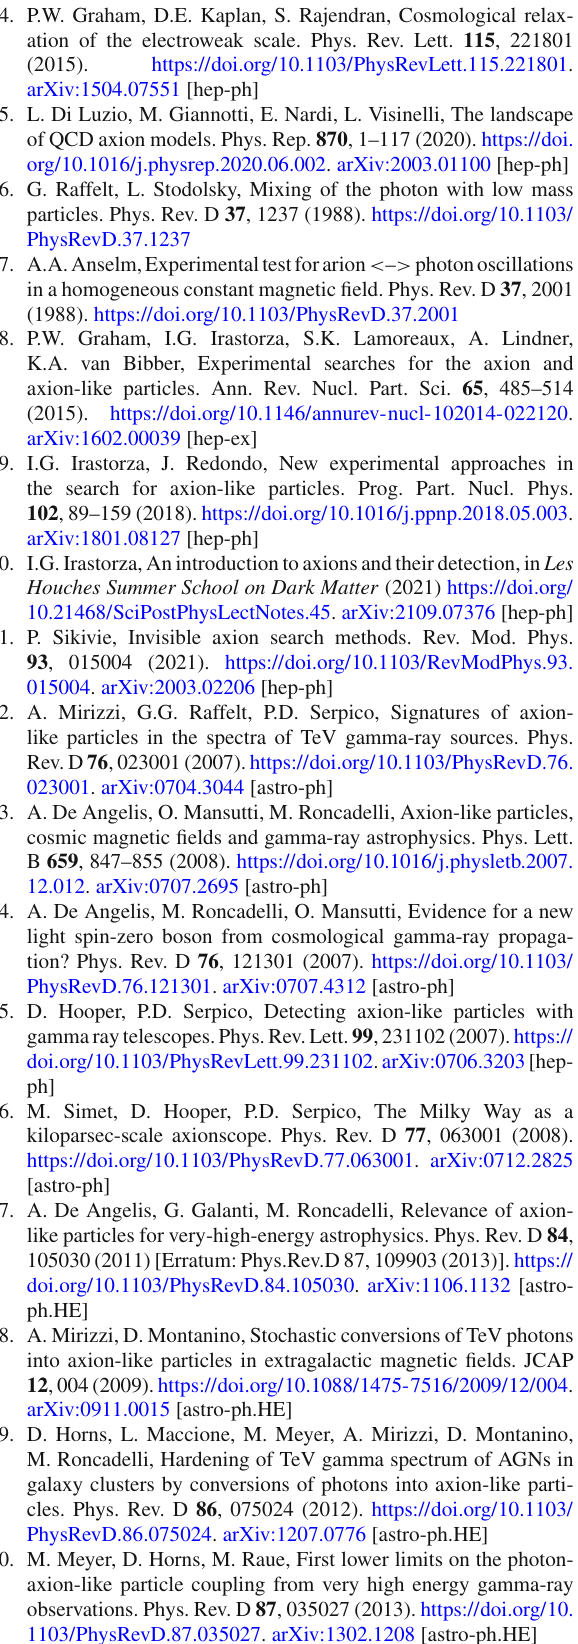
95% confidence level values of g a γ such that χ 2 − χ 2